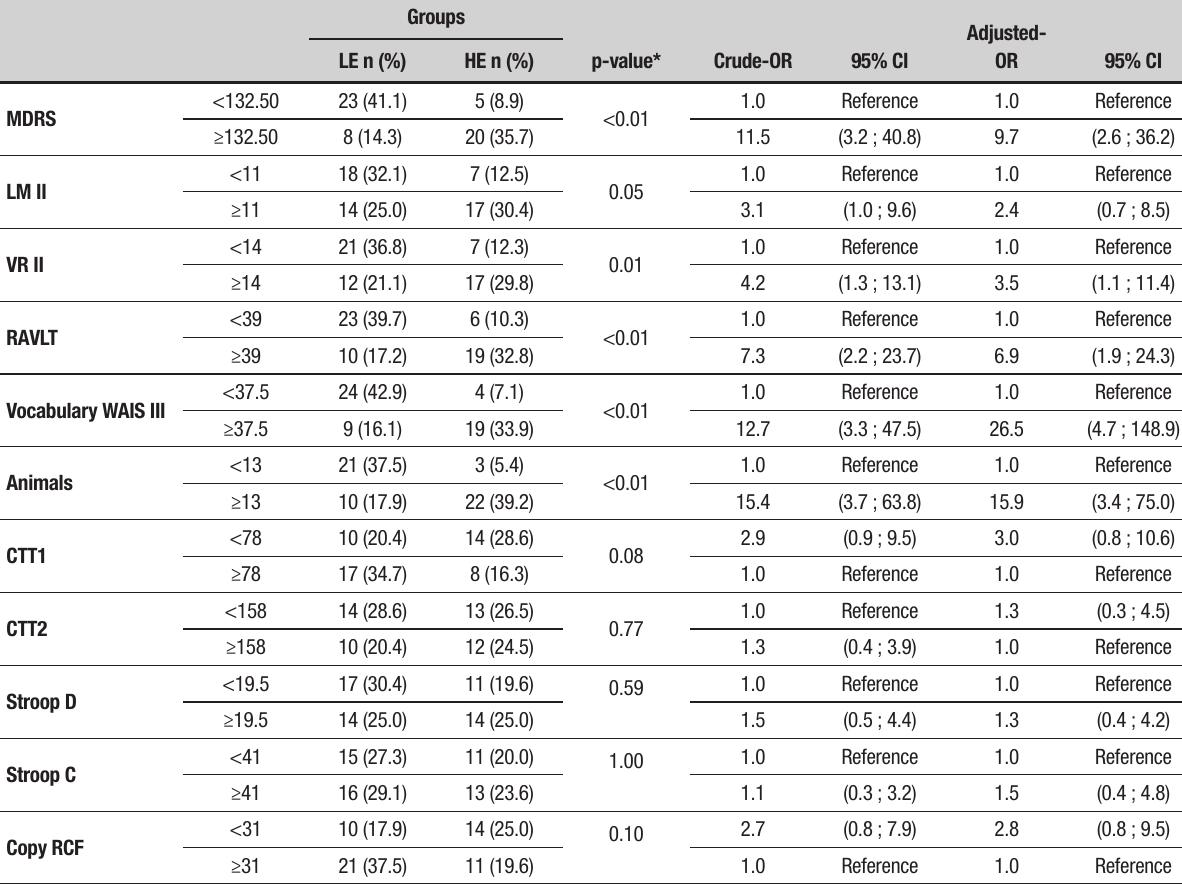
Table 2. Logistic regression analysis for Cognitive Reserve.